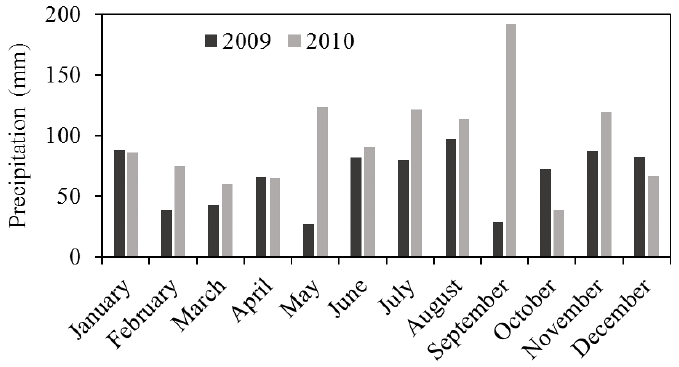
/ 2010 at Zagreb area